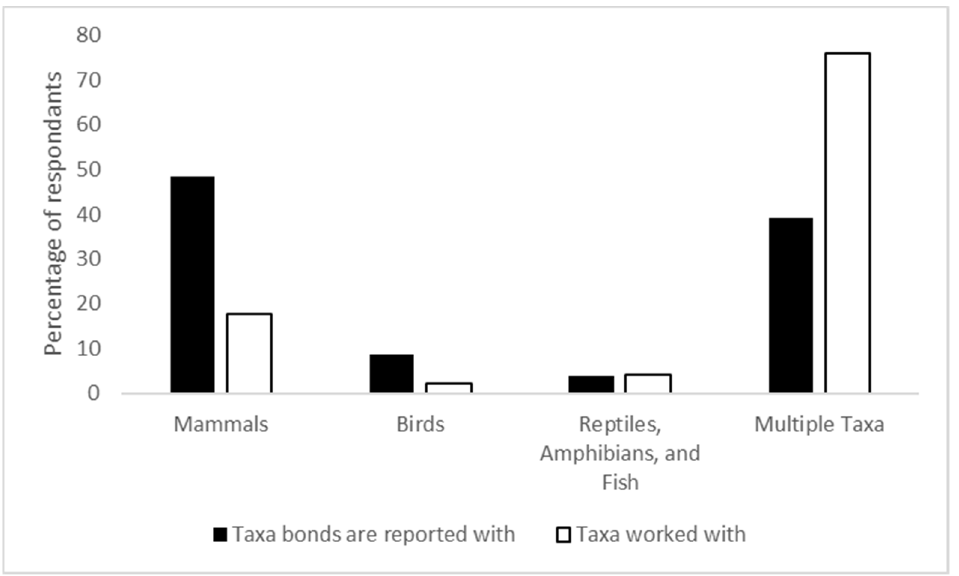
Figure 1. Range of taxa zookeepers have reported working with and bonding with. Dark bars represent taxa with which respondents reported forming bonds with; light bars represent taxa with which respondents reported working with.